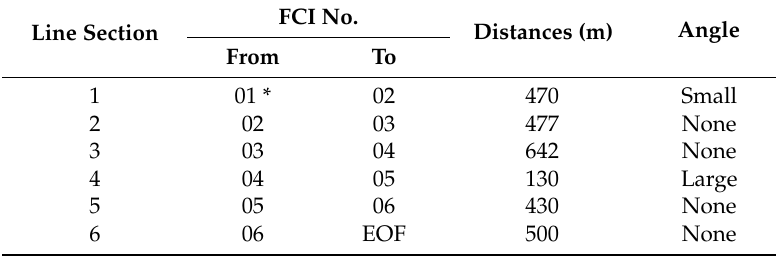
Figure 15. Photographs of the candidate locations for FCI 01 and FCI 02 . Table 1. Topography information of fault current indicator (FCI) placement.